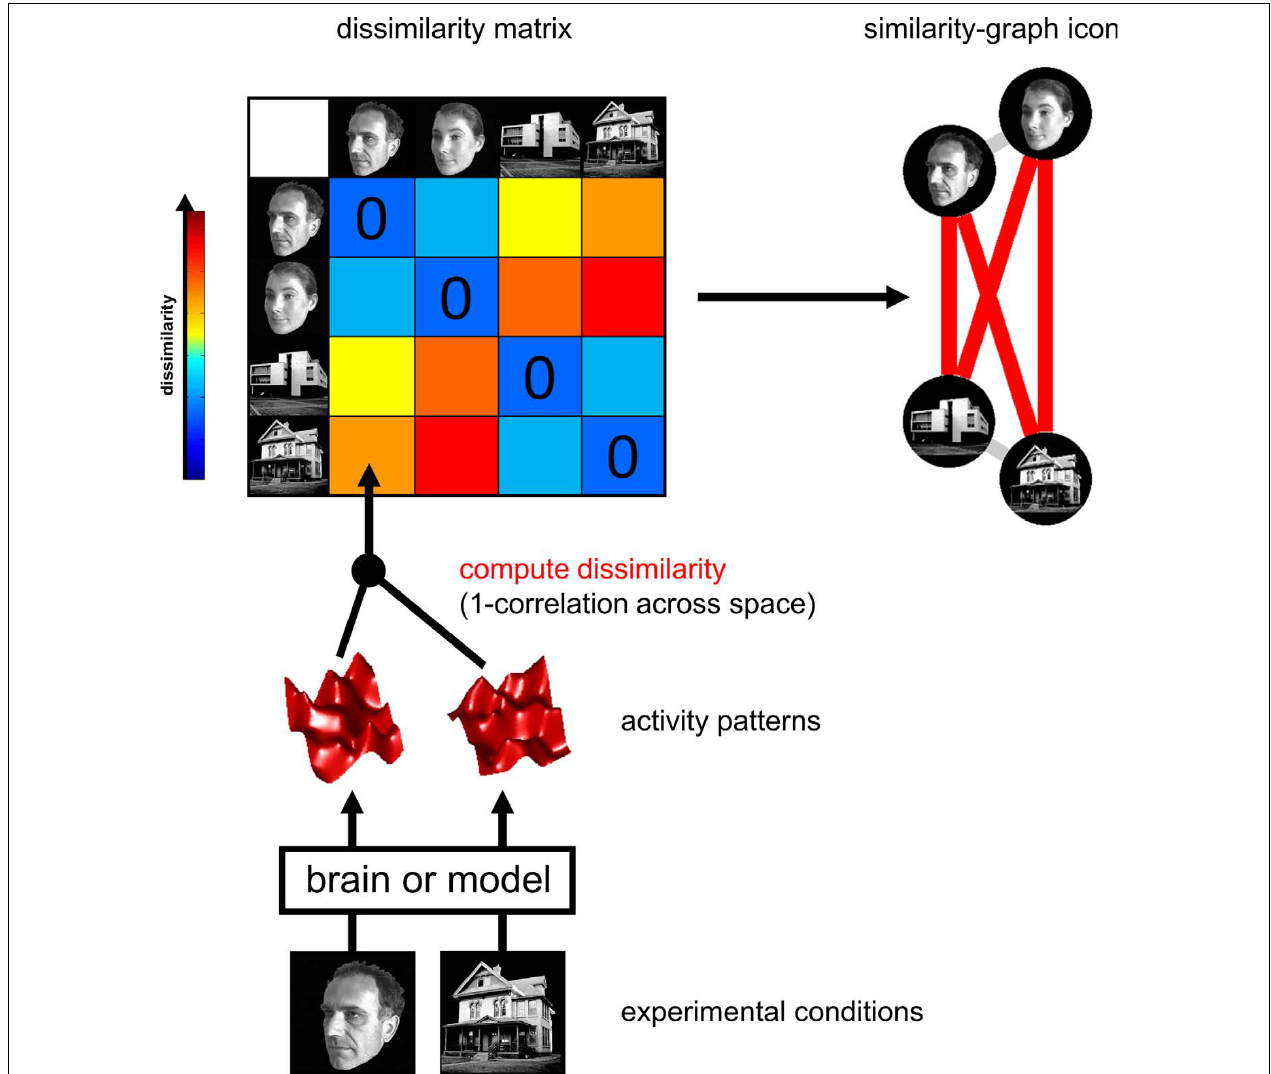
FIGURE 2 | Computation of the representational dissimilarity matrix . For each pair of experimental conditions, the associated activity patterns (in a brain region or model) are compared by spatial correlation. The dissimilarity between them is measured as 1 minus the correlation (0 for perfect correlation, 1 for no correlation, 2 for perfect anticorrelation). These dissimilarities for all pairs of